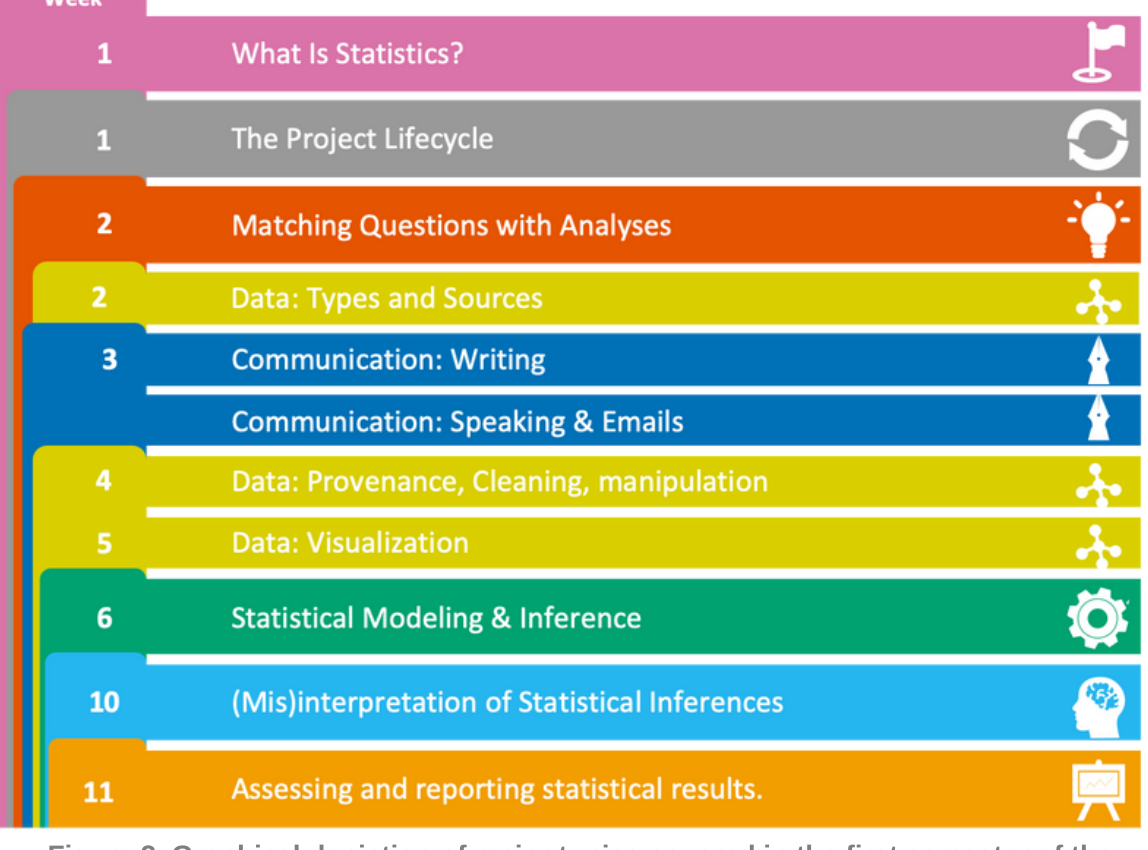
Figure 2. Graphical depiction of major topics covered in the first semester of the Statistics Practicum. Color indicates topic groupings, and number indicates the corresponding week of a semester when each topic is introduced (progressing from bottom to top). To each topic there corresponds a module, including online reading and quizzes before class, in-class discussion and/or activities, and—importantly—integration with that week’s partner project work. The curriculum in the second semester of the practicum follows a similar flow, but with a shift in focus to the broader data science environment (e.g., big data, predictive analytics, ethics in artificial intelligence, etc.) and without the modules on communication. Note. Figure icons from